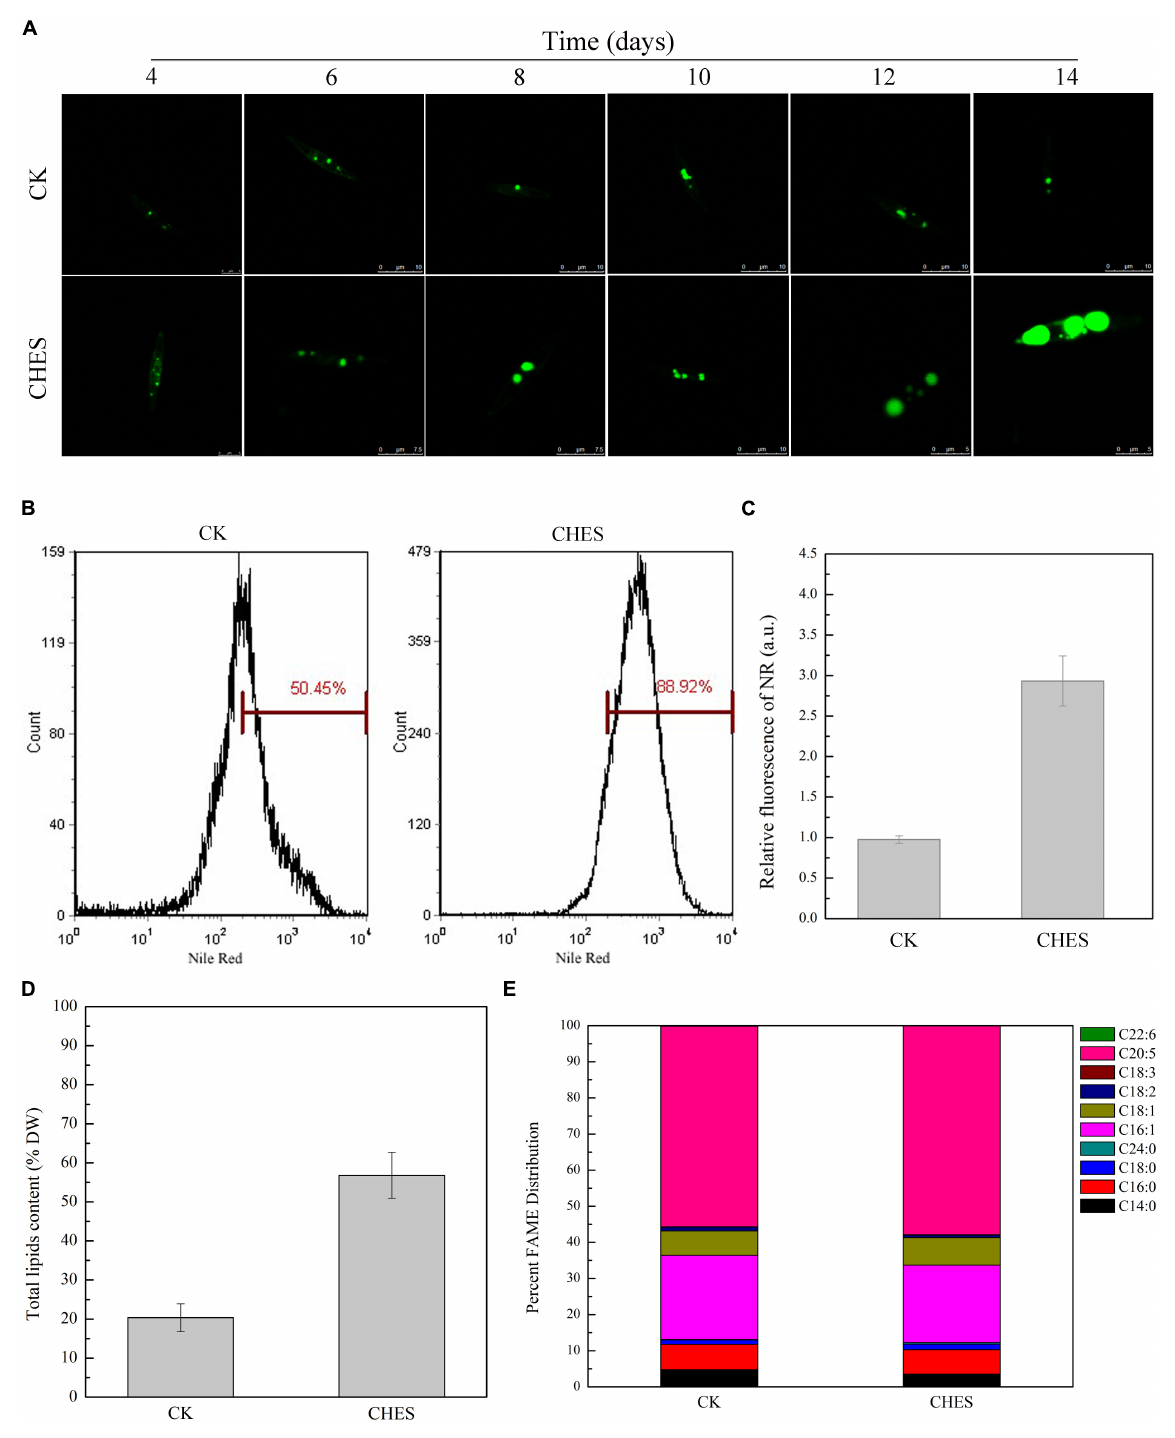
FIGURE2 Fatty acid accumulation and changes in fatty acids composition under CHES treatment in P. tricornutum . (A) TAGs content was examined with BODIPY 505/515 (Ex: 488 nm, Em: 530 nm). tipical images are presented here. Bar was shown in the figure. Nile Red fluorescence determined by flow cytometer (B) and microtiter plate reader (C) . Nile red fluorescence was determined (Ex = 488 nm; Em = 595 nm). Values represent mean ± SD ( n = 3). (D) Total lipid content was determined after 8 d of culture. (E) Fatty acid composition was assessed by GC-MS after 8 d of